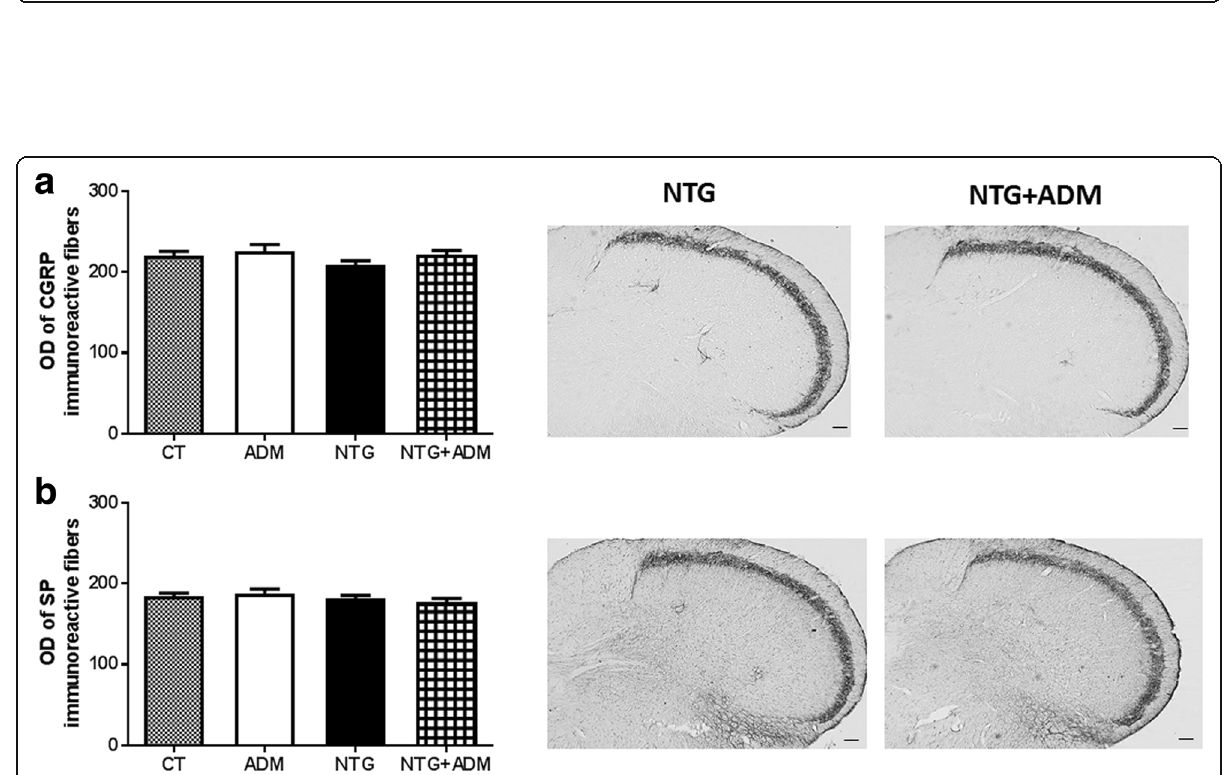
Fig. 2 c-fos, Trpa1, Calca and PPT-A mRNA expression. NTG administration caused a significant increase in the expression of all genes in trigeminal ganglion (TG) and cervical spinal cord (CSC) ipsilateral to the formalin injection, and in medulla-pons (medulla) in toto compared to control group (CT). ADM_12 administration (NTG + ADM group) prevented NTG-induced increase of all four genes in all the areas. No change was observed in gene expression levels when ADM_12 was administered in association with NTG vehicle (ADM group). Data are expressed as mean ± SEM. ANOVA followed by Tukey ’ s Multiple Comparison Test, ** p < 0.01 and *** p < 0.001 vs CT and ADM; °°° p < 0.001 vs NTG; # p < 0.05 vs ADM